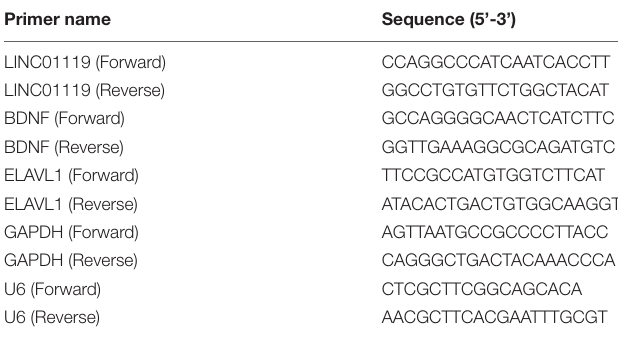
TABLE 1 | Information of the sequences of qPCR primer